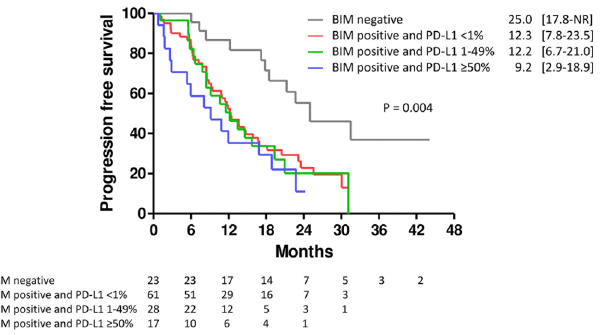
Figure 5. Kaplan–Meier analysis of progression-free survival among patients with different BIM and PD-L1 expression levels. The patients with BIM expression had shorter progression-free survival than those without BIM expression, regardless of PD-L1